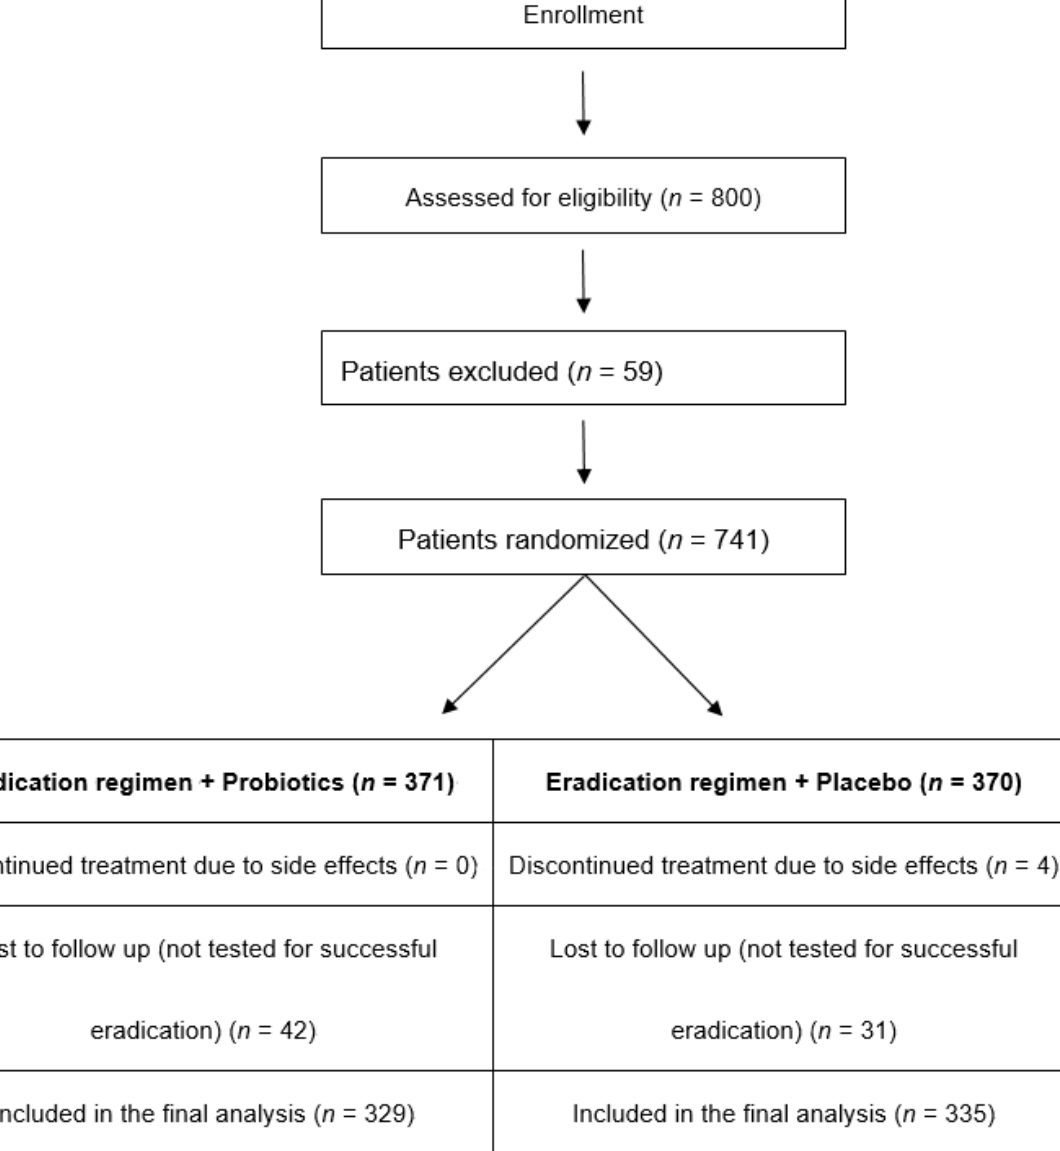
Figure 1. Flow diagram of patients included in the study.